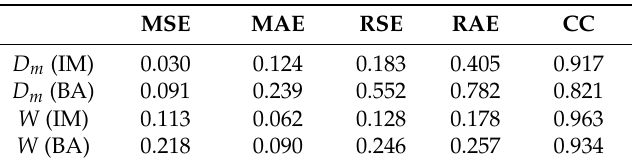
Figure 10. Comparison between the disdrometer data and DSD retrieved by the simulated data: ( a ) D m by the inverse model; ( b ) W by the inverse model; ( c ) D m by the Bayesian approach; and ( d ) W by the Bayesian approach. The red curve indicates the abscissa is identical to the ordinate. Table 3. Mean square error (MSE), mean absolute error, relative square error (RSE), relative absolute error (RAE), and correlation coefficient (CC) for D m and W obtained by the inverse model (IM) and Bayesian approach (BA).